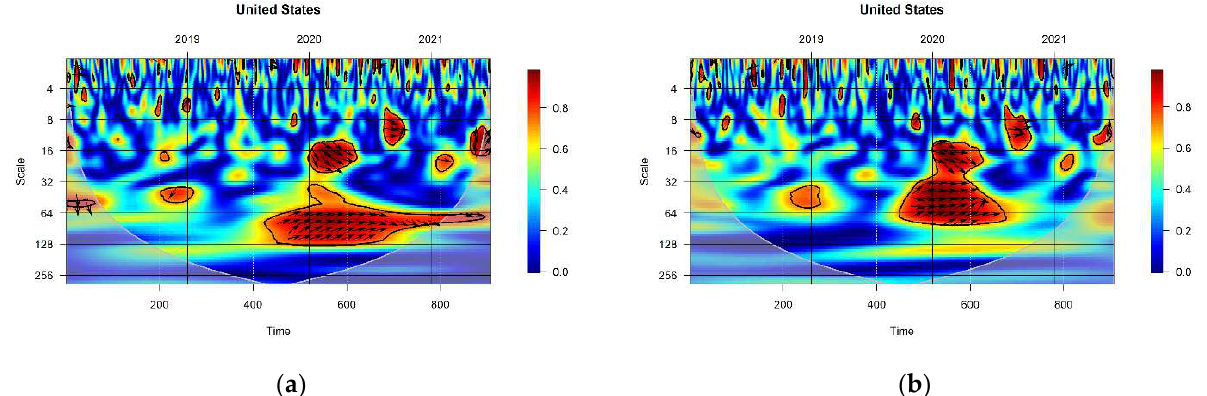
Figure 1. Wavelet Coherence Heatmaps. ( a ) Stock-Bitcoin Comovements; ( b ) Stock-Ethereum Comovements. Notes: The times on the horizontal axis of wavelet coherence map dates correspond